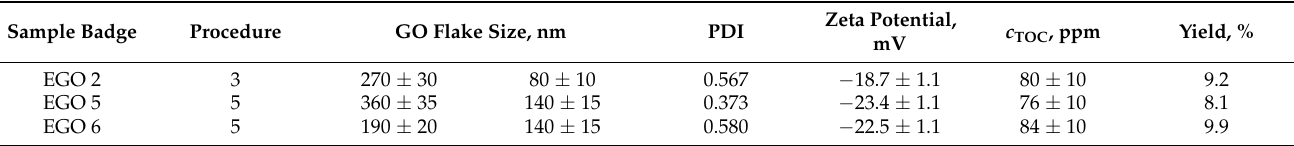
Table 4. Zeta potential, EGO flake sizes, and total organic carbon concentration in aqueous dispersions ( n = 3, p =